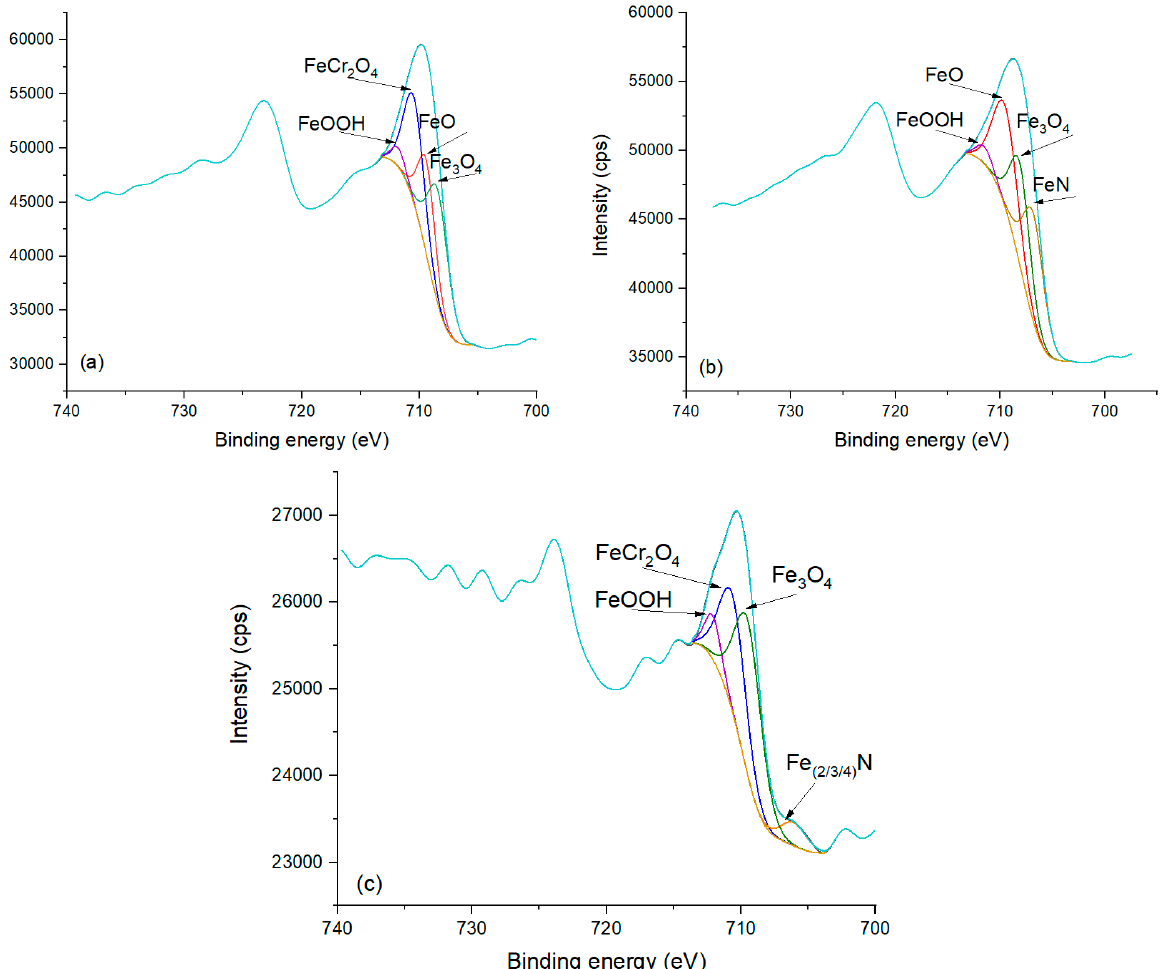
Figure 6. XPS spectra of Fe2p3/2 (and its deconvolution) of the samples processed by SSONPE using ( a ) 20 wt% urea, ( b ) 30 wt% urea and ( c ) 40 wt%